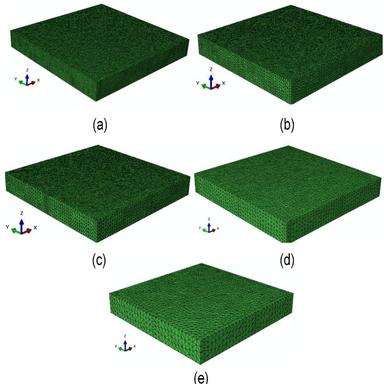
Unit cell models of various sizes (ƒ): (a) ƒ = 0.08 mm; (b) ƒ = 0.10 mm; (c) ƒ = 0.12 mm; (d) ƒ = 0.15 mm; (e) ƒ = 0.20 mm.